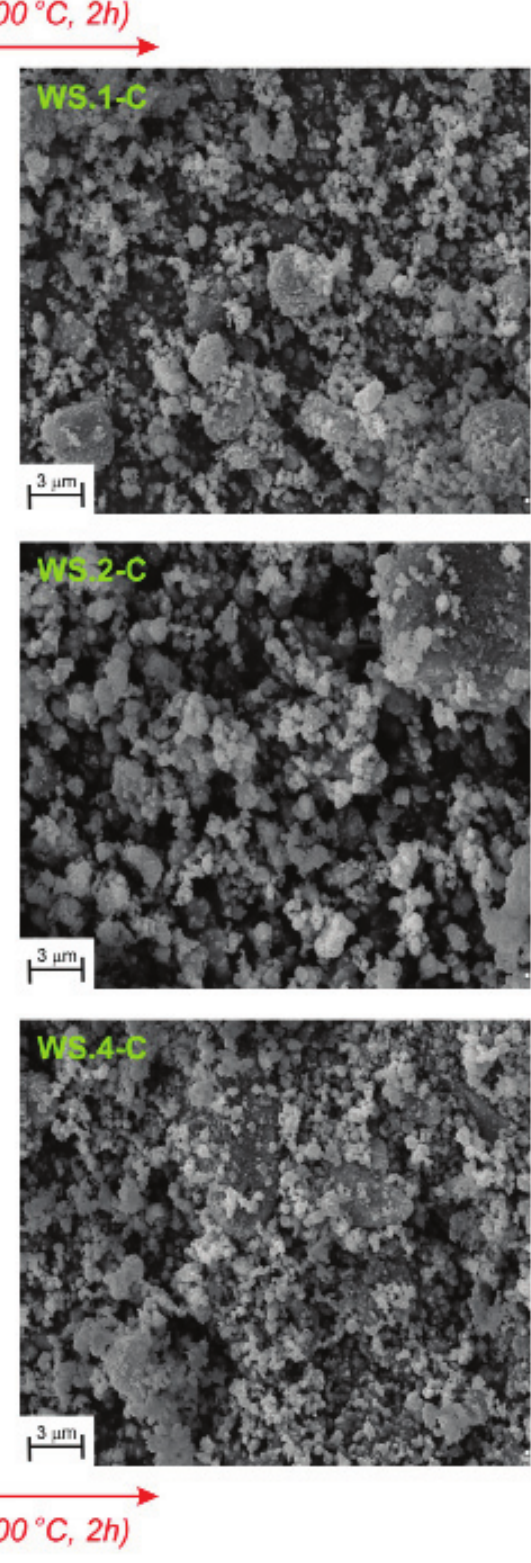
Figure 4: SEM images of MgO-ZrO